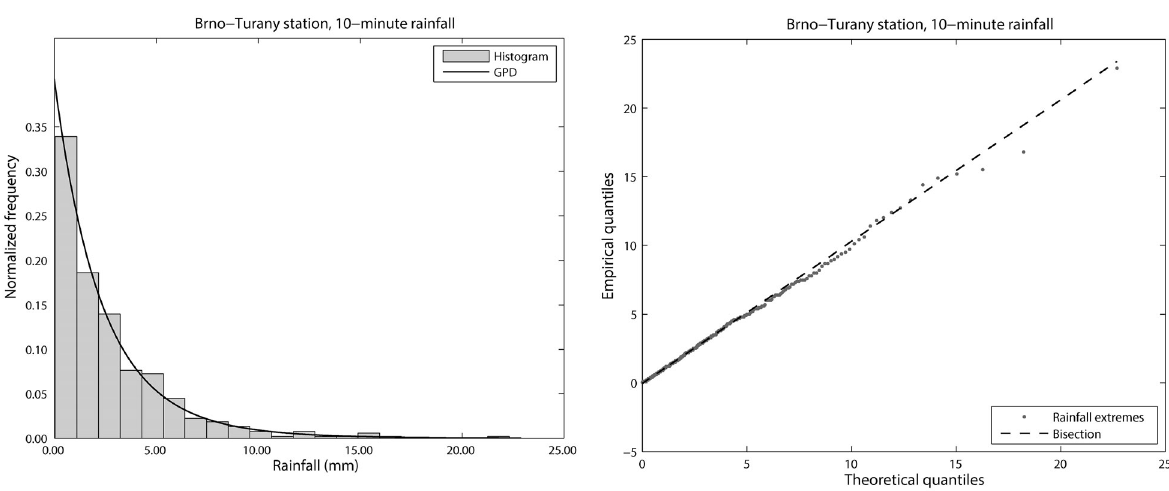
Fig. 3. Histogram and Q–Q plot following GP distribution for the aggregation level of 10 min at the Brno-Tu ř any station.